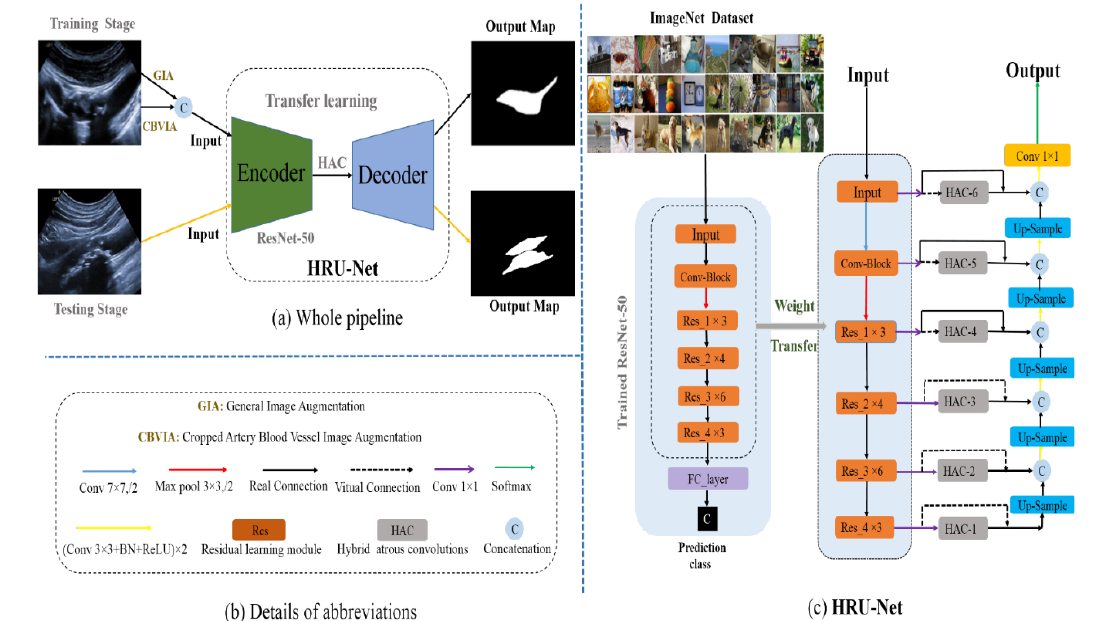
Figure 3. HRU-Net transfer learning for segmenting carotid artery plaques in ultrasound